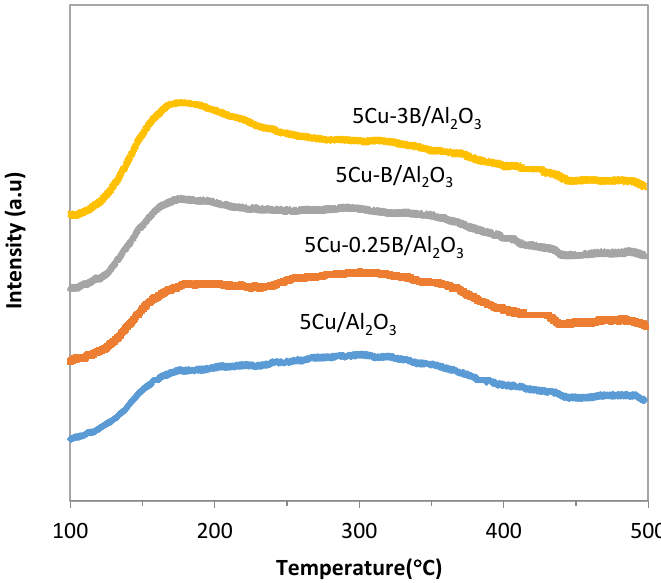
Figure 3. NH 3 -TPD profiles of the catalysts.